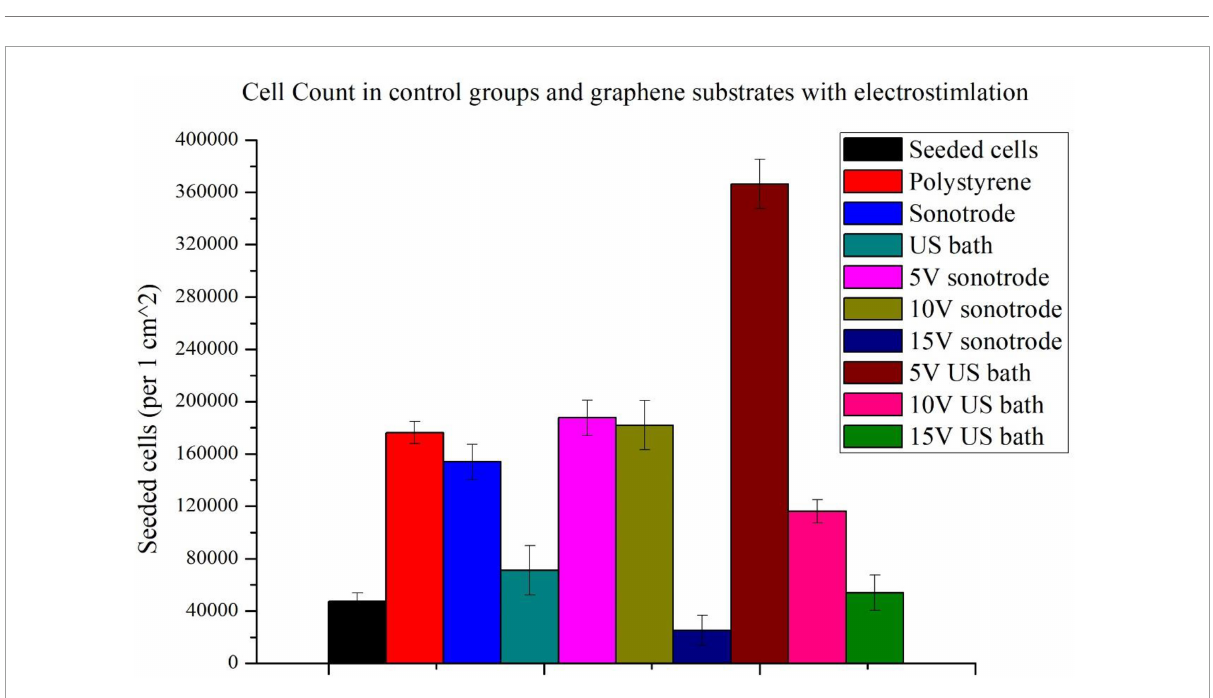
FIGURE4 Comparison of cell counts: seeded, cultured on polystyrene substrate and graphene substrates made with inks sonicated using the sonotrode and ultrasonic bath with and without electrostimulation (5, 10, and 15